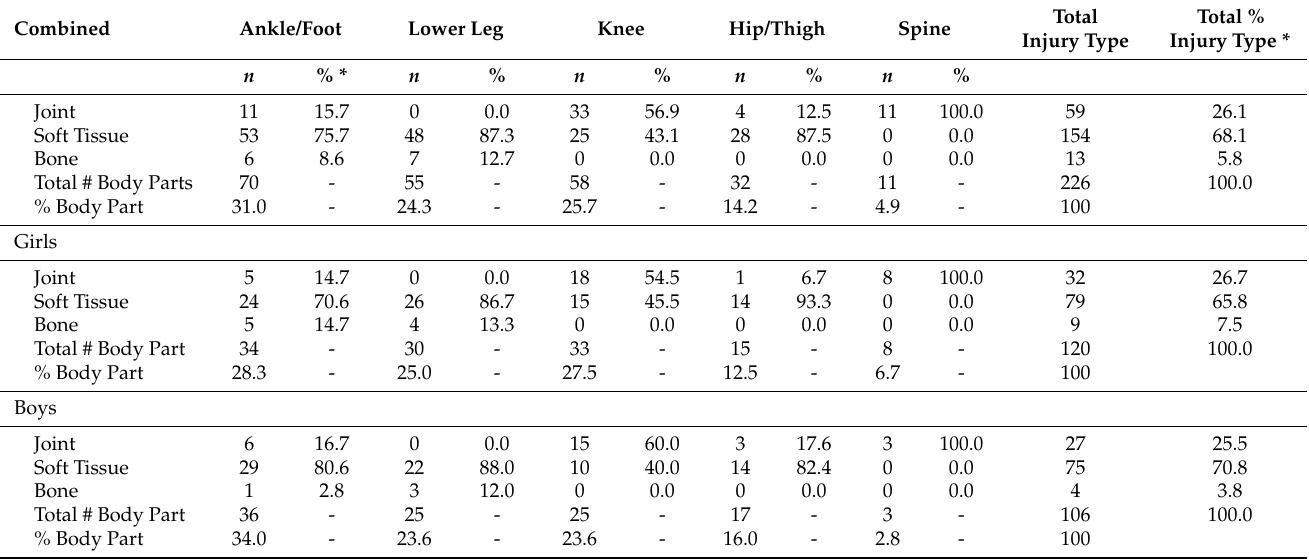
Table 1. Injuries by sex, body part, and injury type for the DREAMFAR training program.